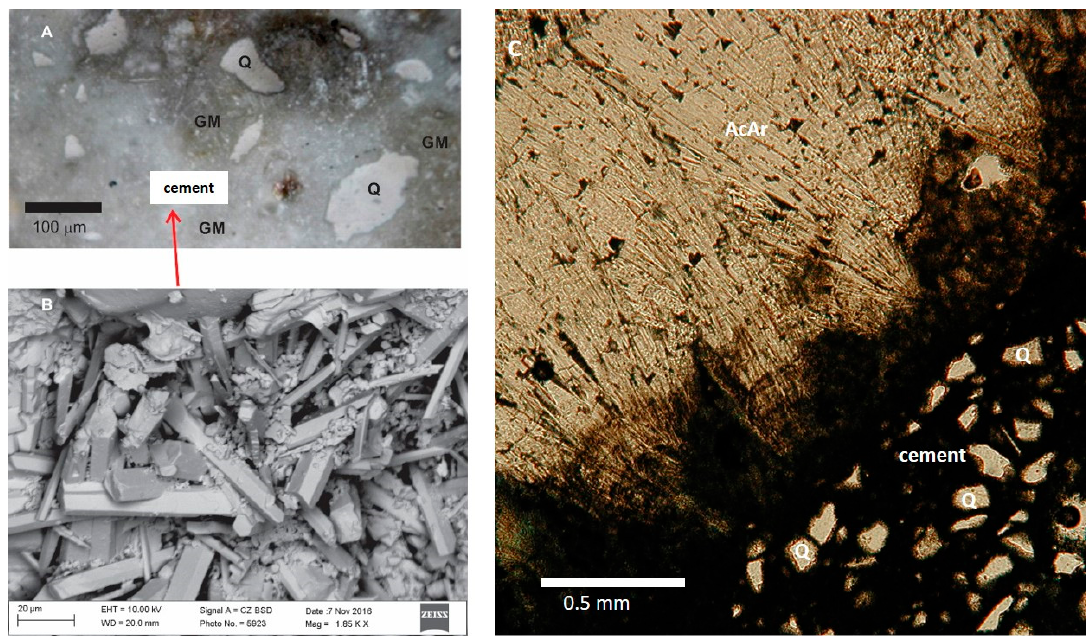
Figure 3. ( A ) Optical micrograph of polished carbonate crust sample (GM = groundmass (grey aragonite cement with non-carbonate inclusions), Q = quartz); ( B ) SEM image of white aragonite cement crystals coated with platinum; ( C ) Optical micrograph (ppl) of thin section showing fractured sandstone (lower right corner) lined with large aragonitic botryoids (i.e., AcAr = acicular aragonite).